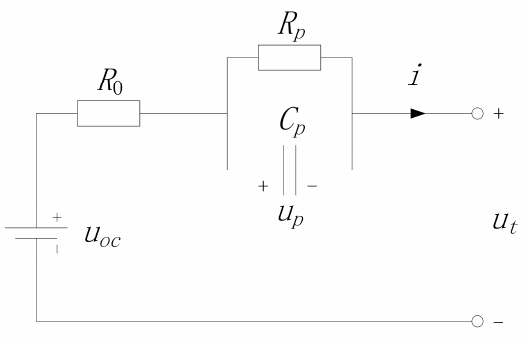
Figure 1. Thevenin Model.